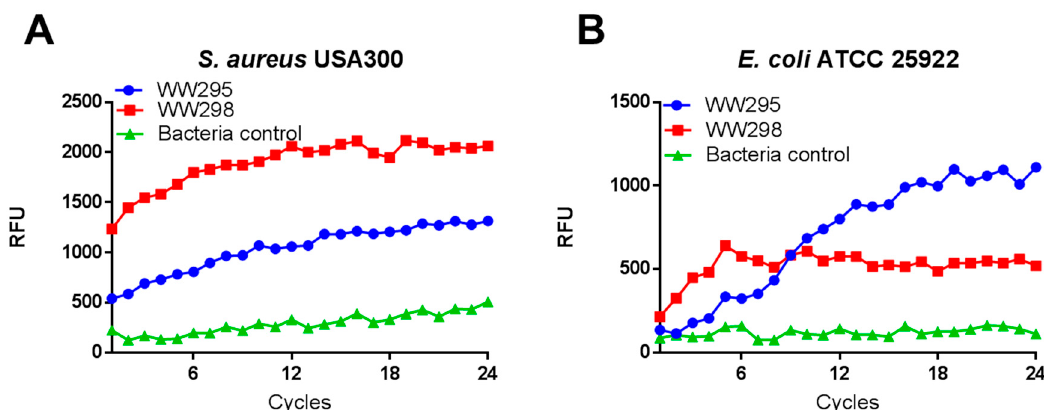
Figure 3. Membrane permeation assay of WW295 and WW298 against ( A ) S. aureus USA300 and ( B ) E. coli . The plots show the fluorescence buildup of propidium iodide with time due to the treatment of the peptide at 3.1 µM. Each cycle is 5 min, leading to a total of 2 h. Bacteria cells without any treatment were used as controls to compare effective permeation.